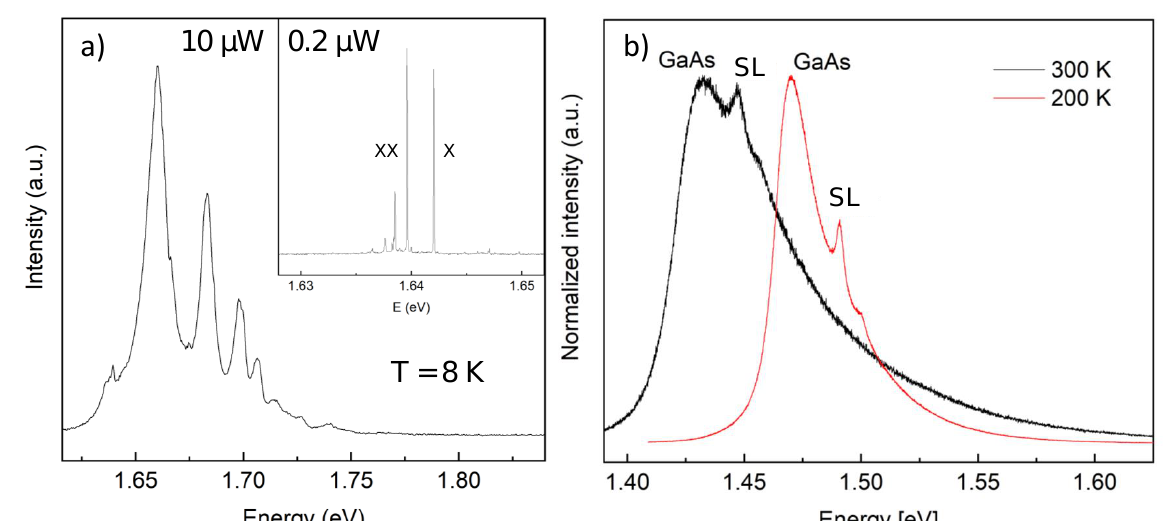
Figure 2. Photoluminescence (PL) data from sample type I taken with a green laser (532 nm). ( a ) Single-dot PL spectrum at low T = 8K with 10µW laser power; inset: PL emission from a single QD with 0.2µW excitation power, exciton (X) and biexciton (XX) peaks are clearly visible; ( b ) PL spectrum at T R (black line) and at 200K (red line) with 0.06mW excitation power. The labels denote the emission from the GaAs substrate (GaAs) and from the superlattice